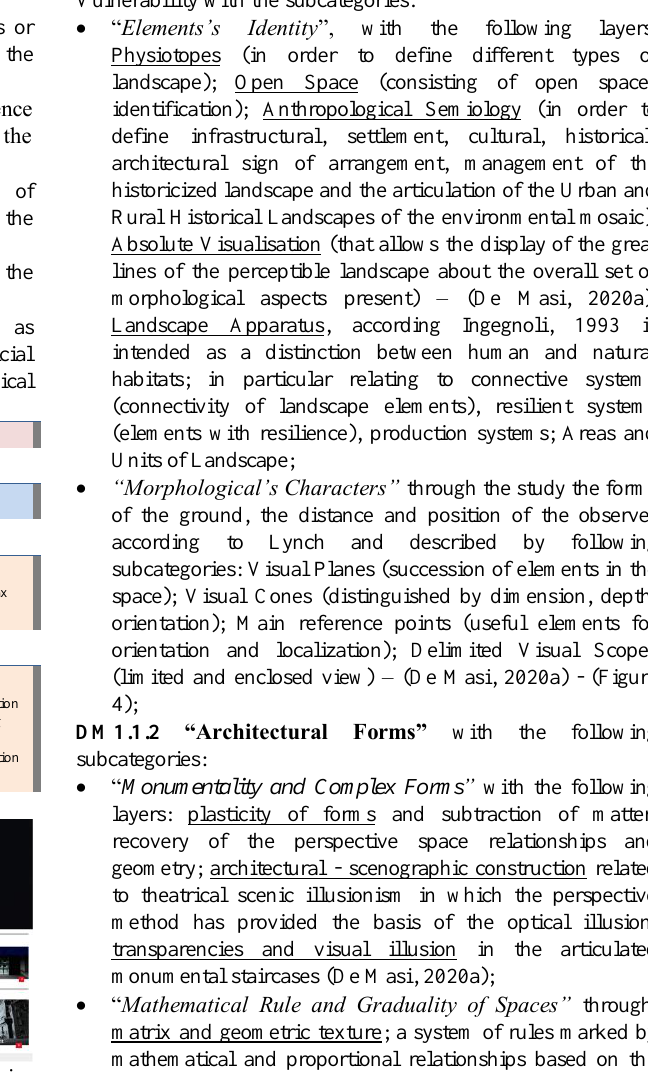
Figure 3 . From left, New Bocconi University headquarters in Milan - Grafton building (2008); Casa del Fascio, Terragni (1936). Cloud Computing Platform’s Homepage: Autodesk Fusion 360 and service integration host (A. De